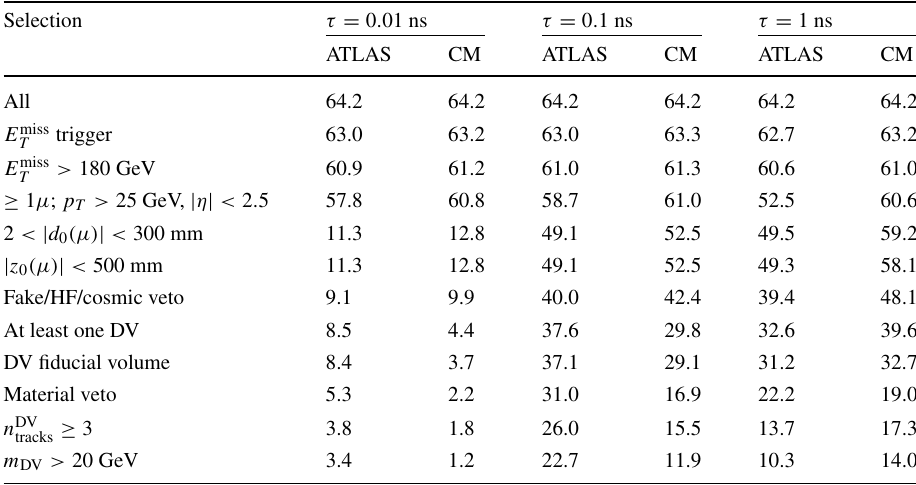
Table 8 Cutflow for the displaced vertex + muon search in the missing transverse energy SR